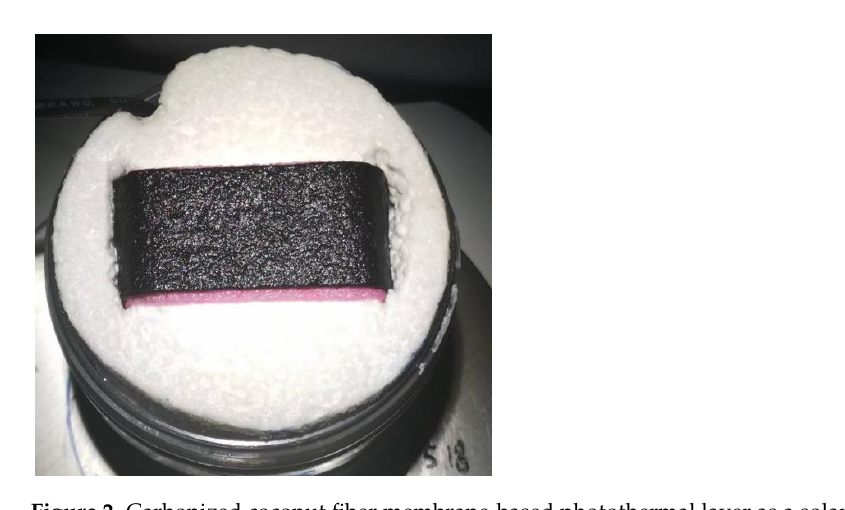
Figure 2. Carbonized coconut fiber membrane-based photothermal layer as a solar evaporator.